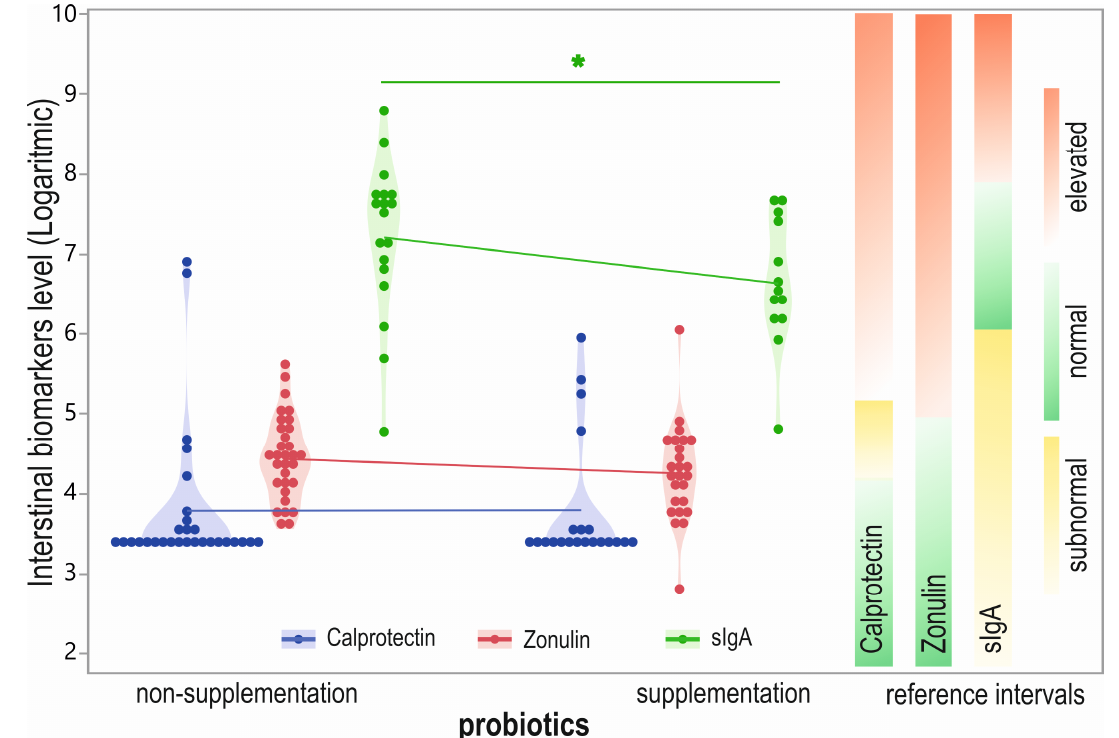
Figure 3. Stool calprotectin, zonulin, and sIgA levels (log transformed) in participants distinguished by probiotic supplementation with biomarkers reference range. Designation: green—normal level; yellow—subnormal or gray-zone; red—elevated level; * p < 0.05.